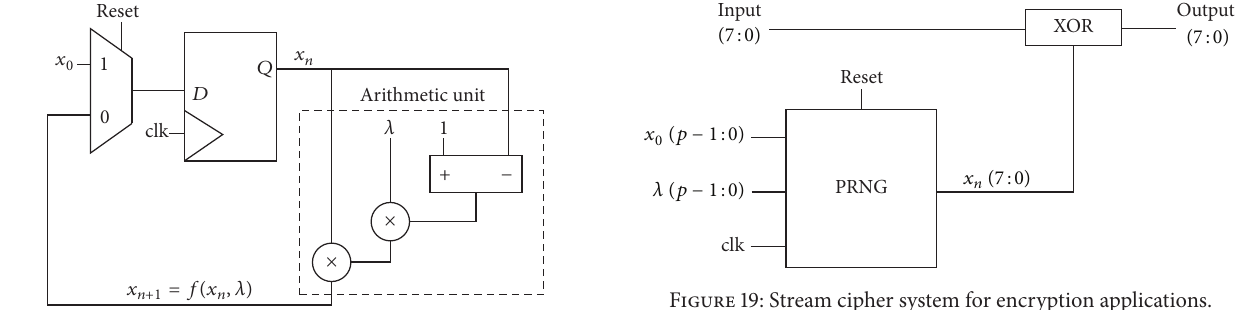
Figure 18: Hardware realization of Pseudo-Random Number Gen- erator.